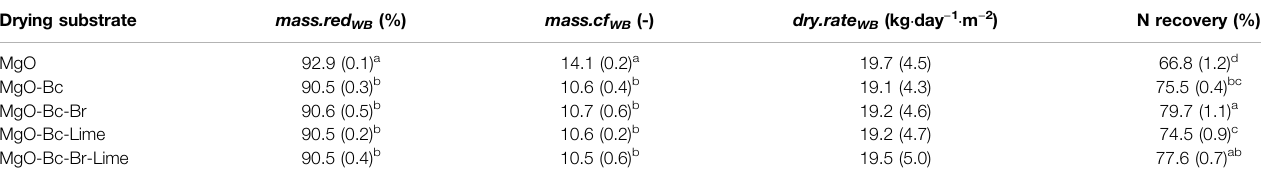
TABLE 3 | The mass reduction ( mass.red WB ), mass concentration factor ( mass.cf WB ), dehydration rate ( dry.rate WB ), and recovery of N after treating urine with MgO-based drying substrates.